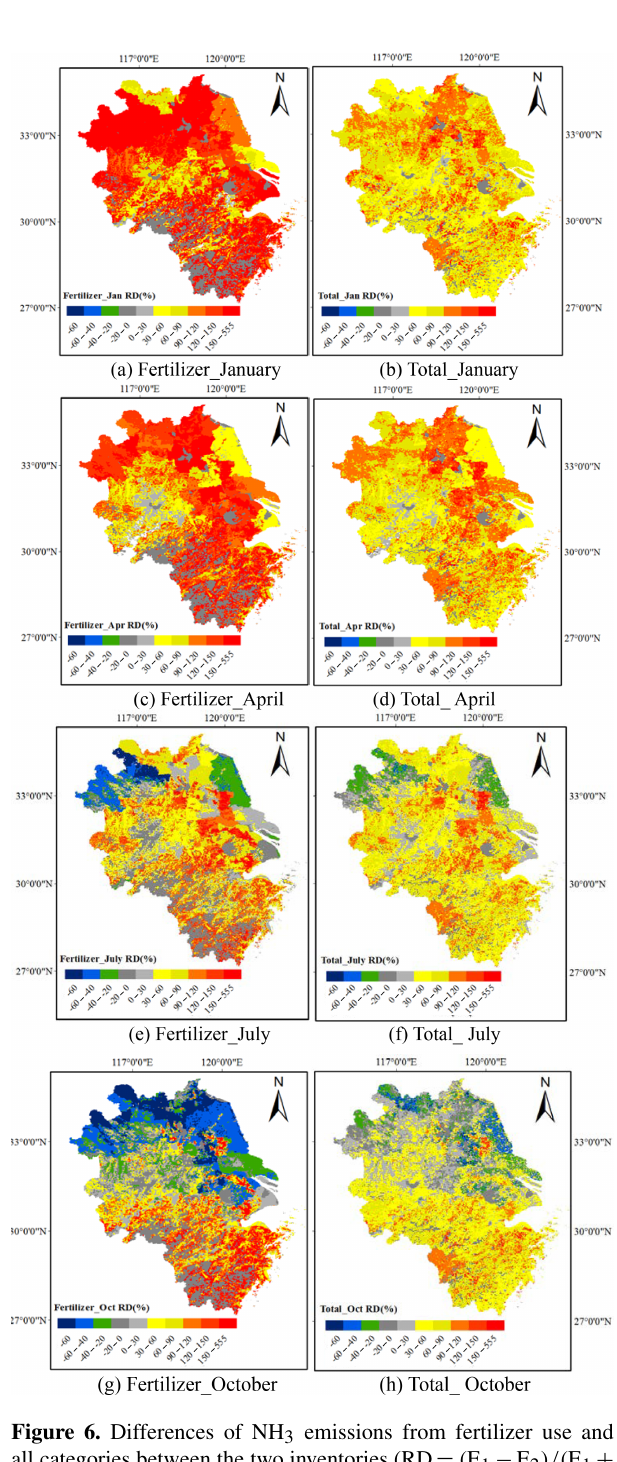
Figure 6. Differences of NH 3 emissions from fertilizer use and all categories between the two inventories (RD = ( E 1 − E 2 )/( E 1 + E 2 )/ 2 )